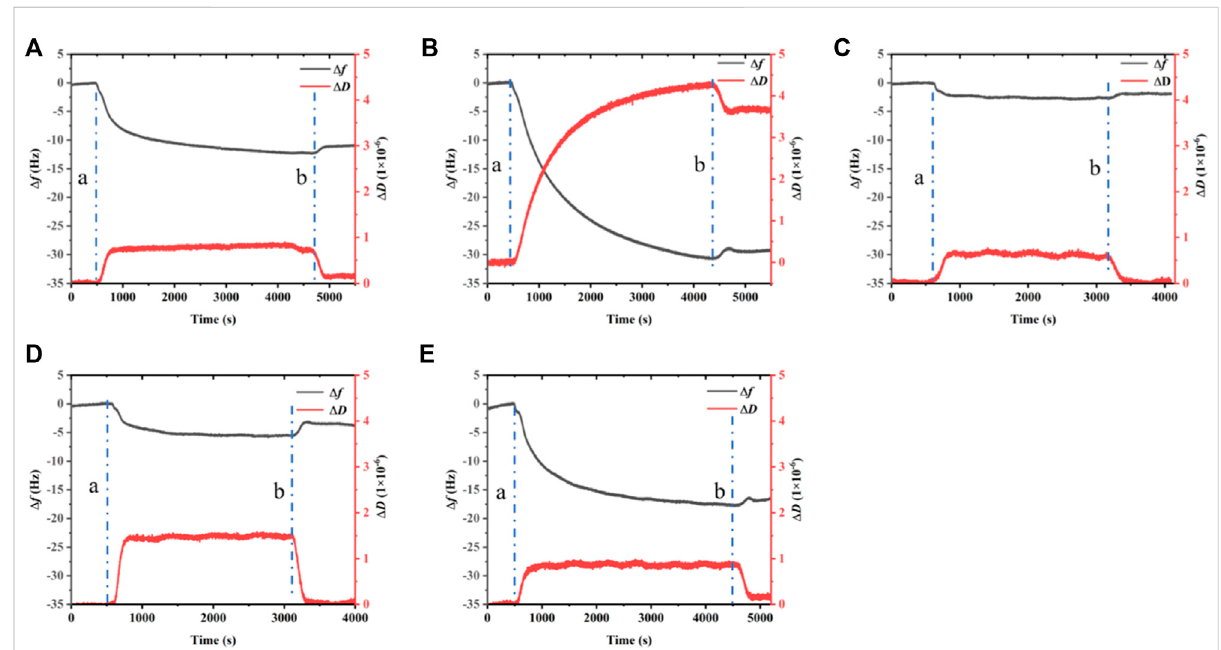
FIGURE 5 Dissipation, frequency of BalCP20-P3 and its mutants on gold-coated quartz crystal sensors. (A) BalCP20-P3. (B) BalCP20-P3-M1. (C) BalCP20-P3-M2. (D) BalCP20-P3-M3. (E) BalCP20-P3-M4. Changes in frequencies (Hz) in black are shown on the primary axis, and changes in dissipation (1 × 10 − 6 ) in red are shown on the secondary axis. (A) Flow of BalCP20-P3 and its mutants solution; (B) Million-Q